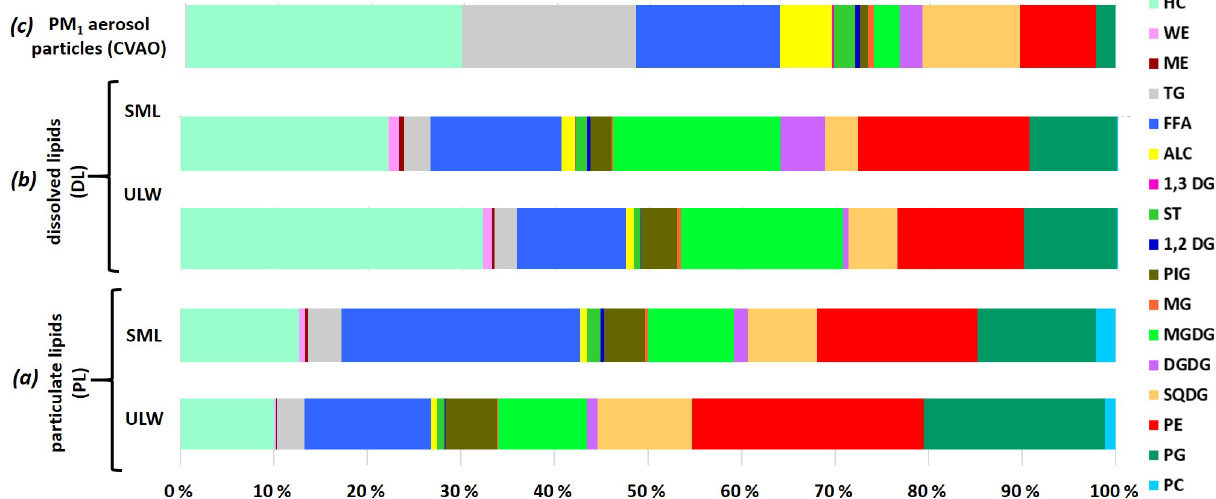
Figure 5. The percentage contribution of the individual lipid classes to the total lipids in the (a) particulate and (b) dissolved fraction in seawater (differentiation between ULW and SML) and on (c) PM 1 aerosol particles at the CVAO.